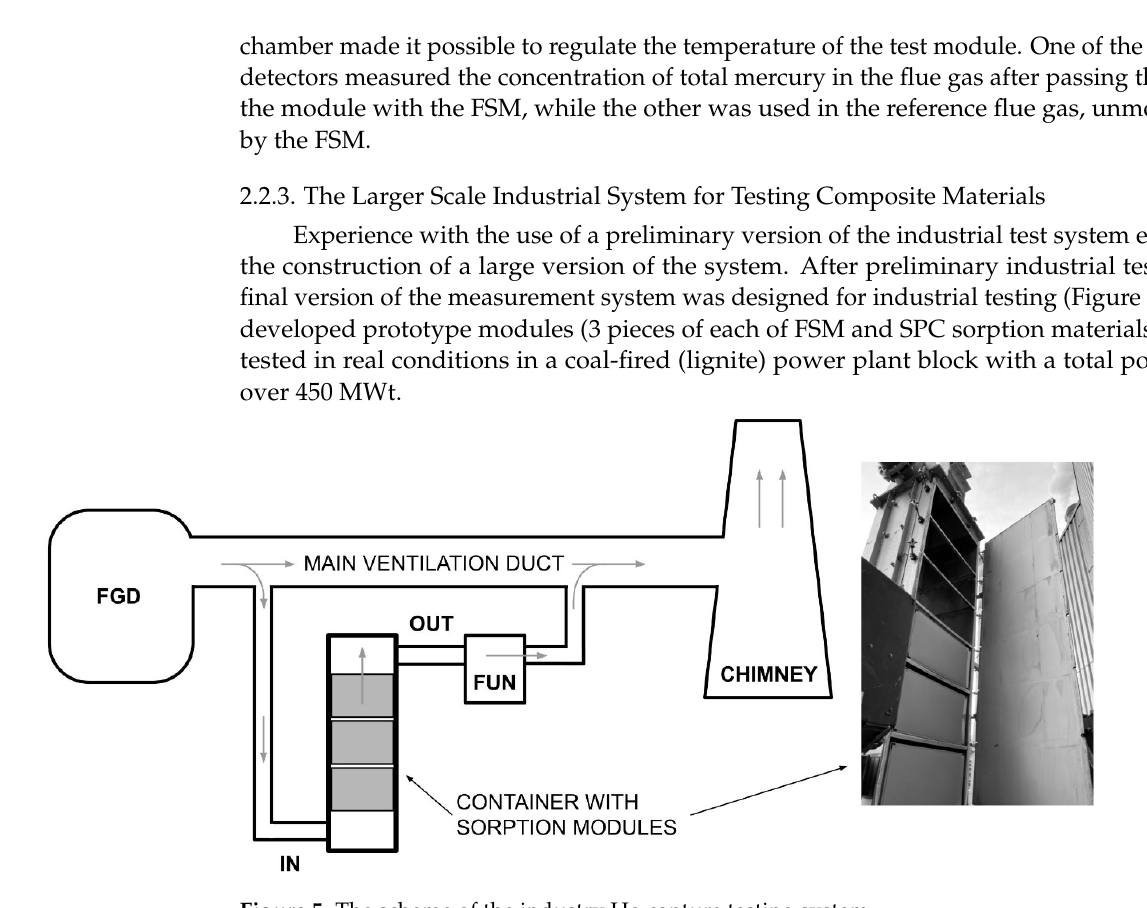
Figure 5. The scheme of the industry Hg capture testing system.